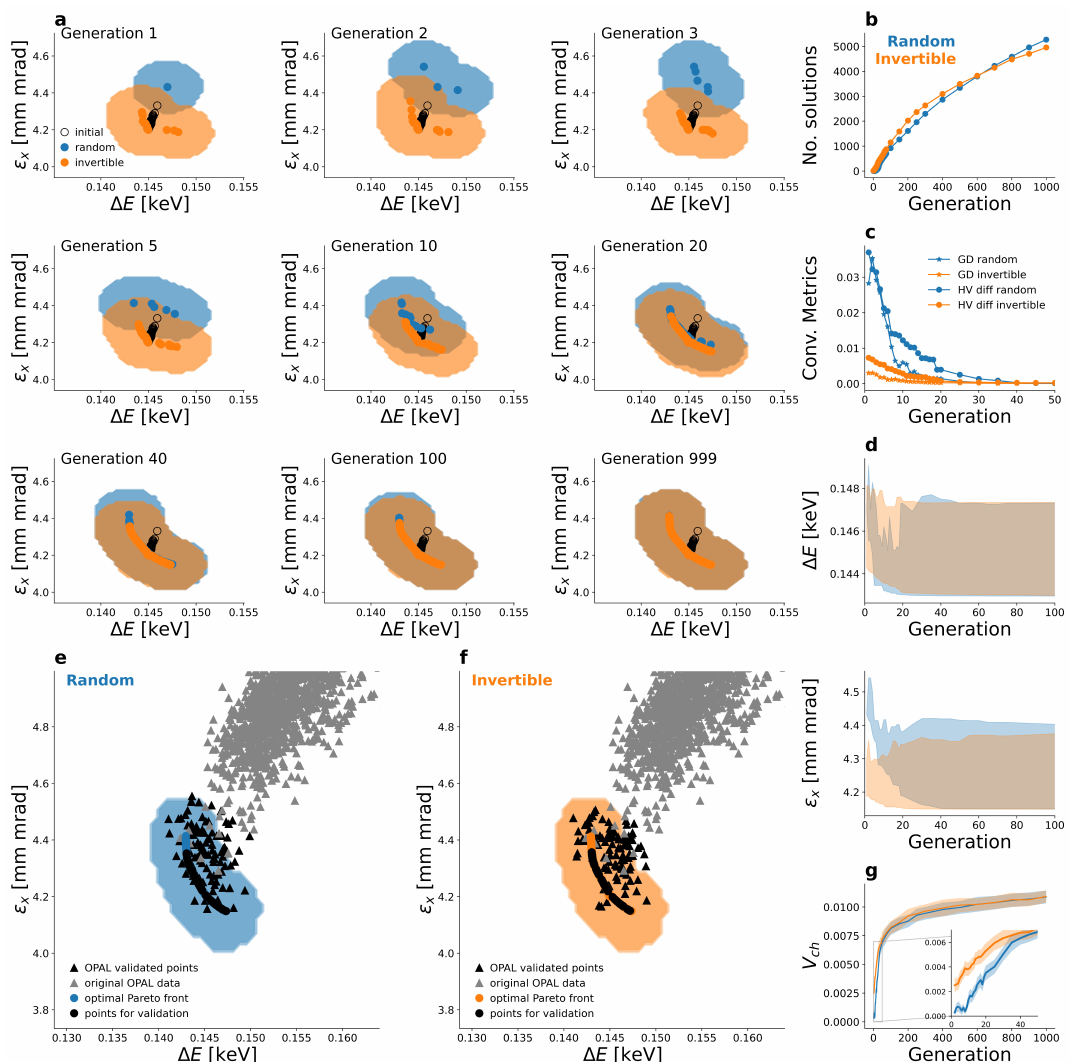
Figure 6. Convergence of the IsoDAR optimisation. The items coloured blue belong to the random initialisation, and the orange ones indicate the usage of the invertible model for initialisation. ( a ) Two-dimensional projection of the objective space for different generations. The dots are the predictions, and the shaded areas depict the prediction uncertainty at 90% confidence as estimated on the test set. The black circles show the initial values for the biased optimisation. ( b ) Number of non-dominated solutions. ( c ) Convergence metrics: Generational Distance (GD) (dots) and Hypervolume Difference (HV diff) (stars) to compare the two optimisation approaches. ( d ) Range (minimum/maximum) of the non-dominated set in objective space. ( e , f ) Validation with OPAL. Both figures show the objective space with OPAL validated points in black (triangles), the original OPAL data points in grey (triangles), the 90 percentile (shaded area) of the optimal Pareto front (blue and orange dots) and 100 randomly chosen points of the optimal Pareto front for validation (black dots). ( g ) Estimated volume of the convex hull of the non-dominated set configurations in objective space using the Monte Carlo uncertainty. The solid lines describe the mean values, and the shaded areas mark the mean plus/minus one standard